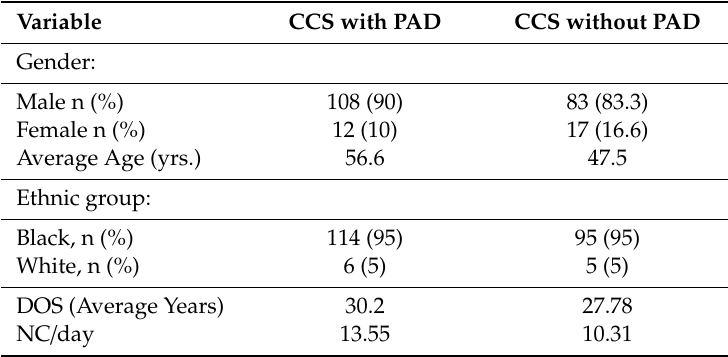
Table 1. Sociodemographic characteristics of the study